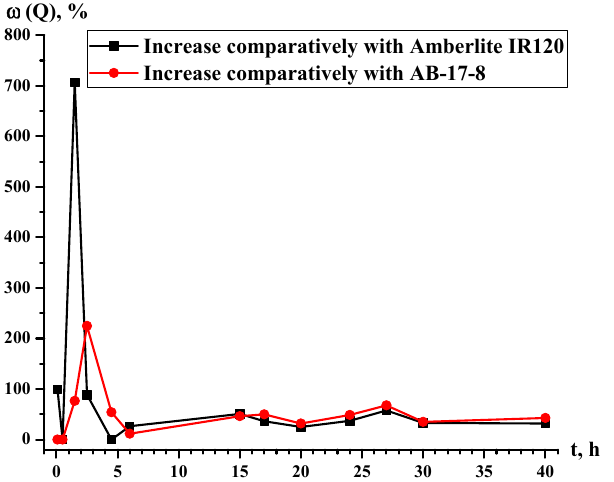
Figure 18. Increase of effective dynamic exchange capacity in interpolymer pair Amberlite IR120:AB-17-8 = 1:5 relative to individual Amberlite IR120 and AB-17-8. Table 6 presents values of growth of effective dynamic exchange capacity of intergel pair compared with individual ion exchangers. Table 6. Increase of effective dynamic exchange capacity in interpolymer pair Amberlite IR120:AB-17-8 = 1:5 compared with individual ion exchangers.